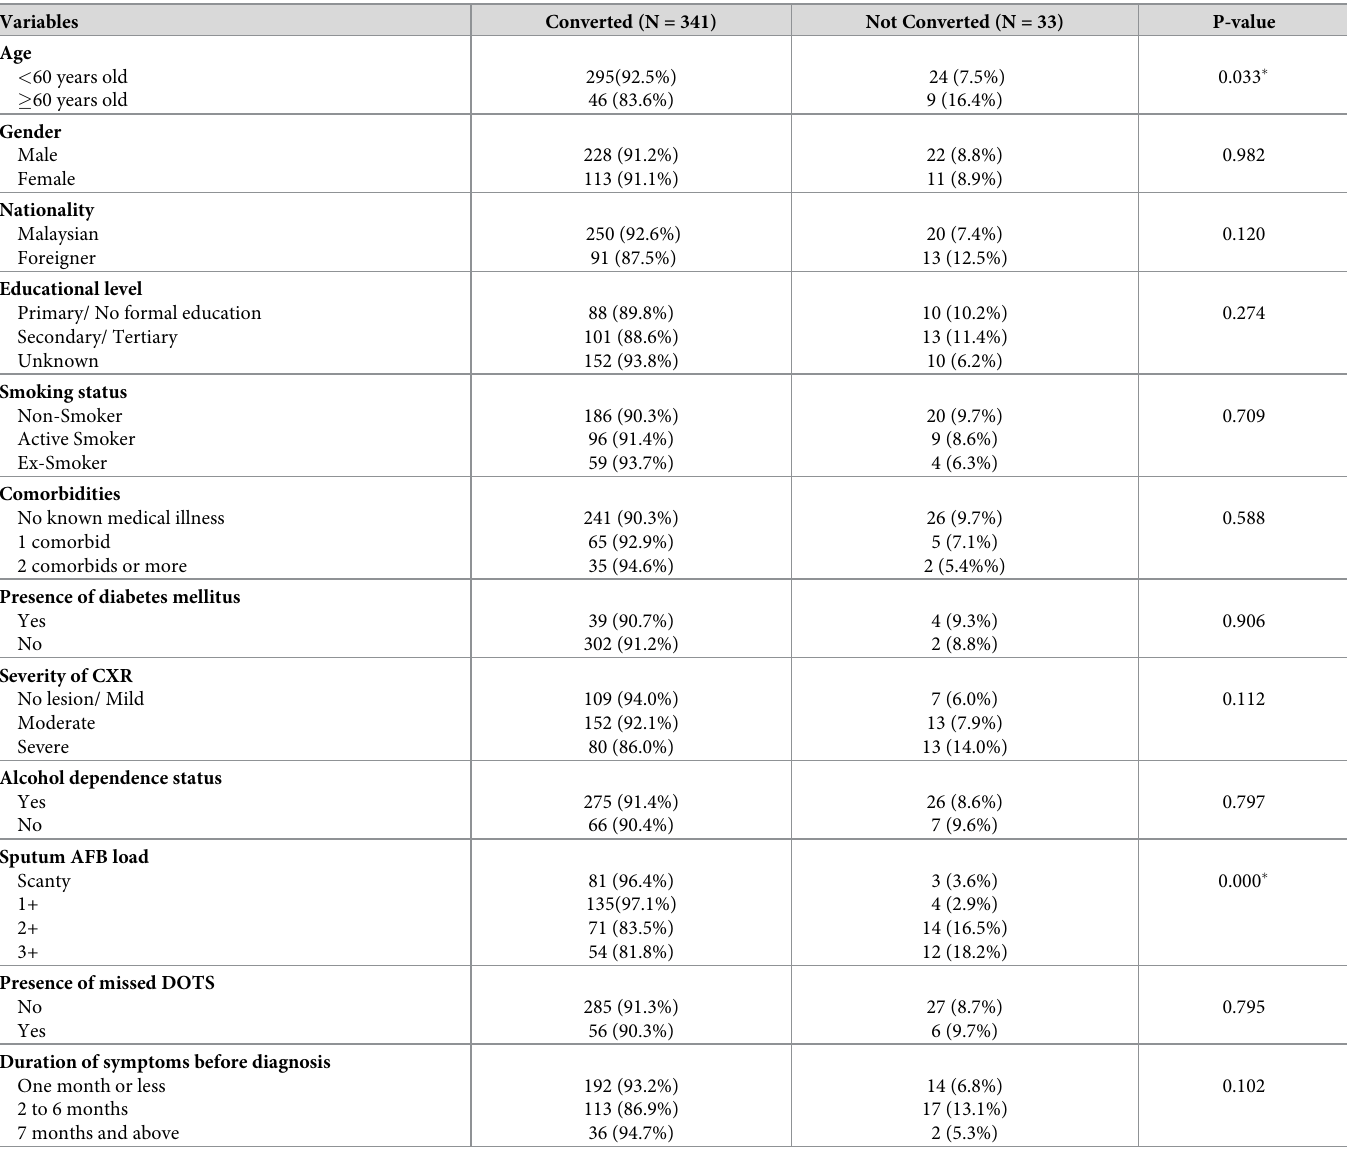
Table 2. Chi-square test for association of sociodemographic and clinical variables with delayed sputum smear conversion.